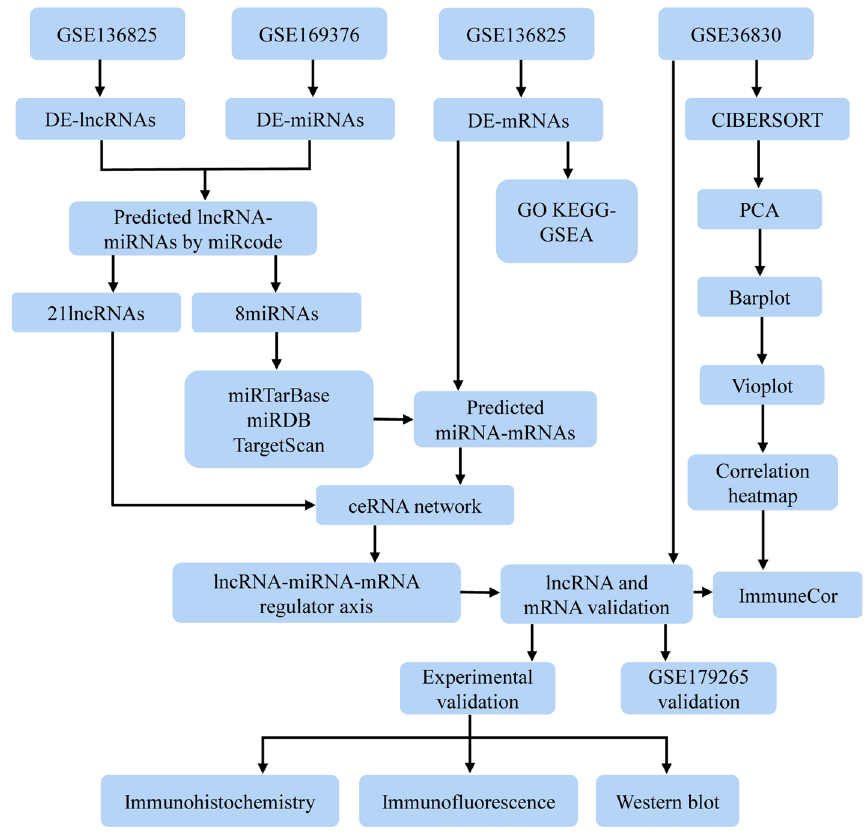
Figure 1. Flow chart of the study design.